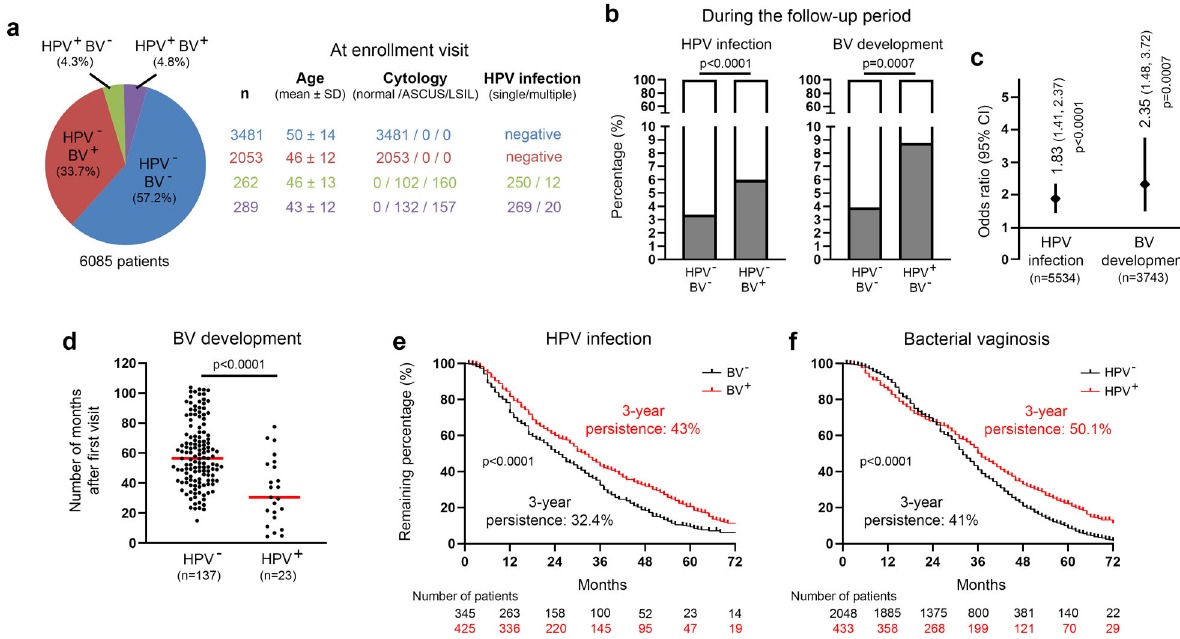
Fig. 1 Retrospective clinical follow-up analysis evaluating the relationship between genital HPV infection and BV occurrence/persistence. a General characteristics of the study population ( n = 6,085). b Probability of high-risk HPV infection or BV development during the follow-up period according to the status for the other gynecological disorder at fi rst (enrollment) visit. c Forest plot showing the odds ratio (OR) and 95% con fi dence intervals (CI) for developing one pathological condition when the other one was preceding in time [HPV infection (OR: 1.83, 95% CI: 1.41 – 2.37); BV development (OR: 2.35, 95% CI: 1.48 – 3.72)]. d Number of months for BV occurrence in HPV-positive and -negative patients. e Kaplan-Meier estimates for the persistence of HPV infection according to the BV status (negative versus positive). The clearance of HPV infections was ascertained by both cytology (Bethesda system) and PCR-based HPV test (Abbott High-risk HPV assay). f Kaplan – Meier curve for the persistence of BV according to the HPV status. Two consecutive negative results (using Hay/Ison grading system) at least 12 months apart were required to consider a patient really/durably cured of BV. P values were determined using two-sided Fisher ’ s exact test b , c , two-sided unpaired t -tests ( d ) and log-rank (Mantel-Cox) test e , f . Source data are provided as a Source Data fi